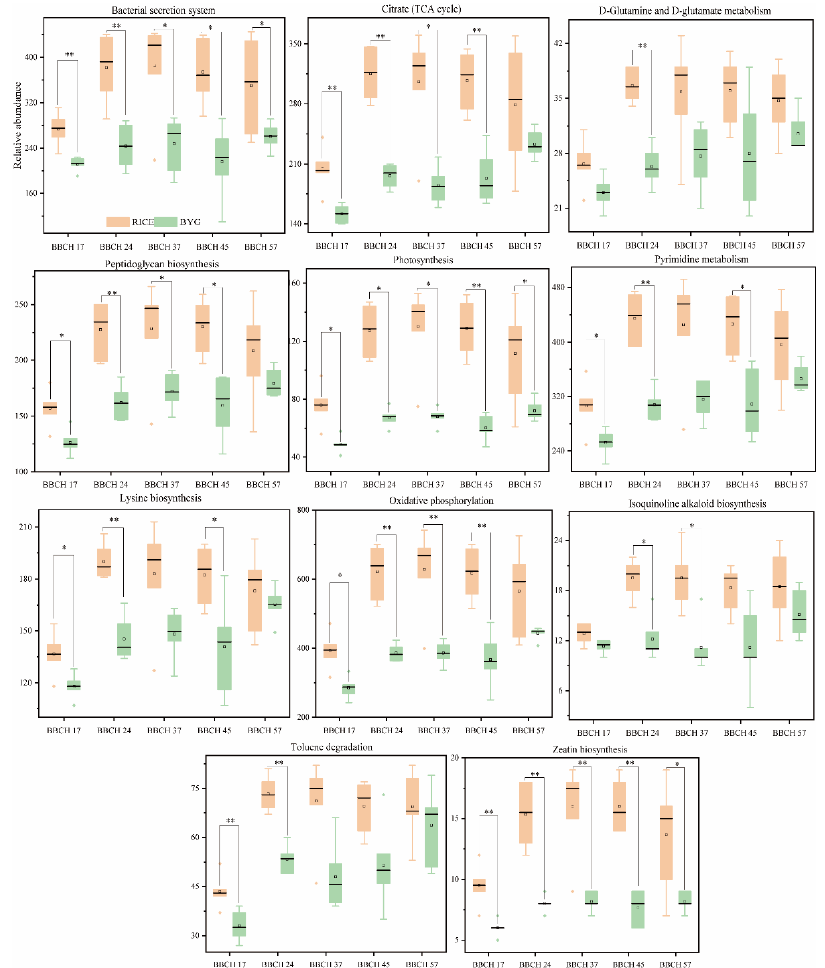
Figure 6. The significant microbial functional features in rice. Significant differences are indicated by asterisks. * p <0.05, ** p < 0.01.